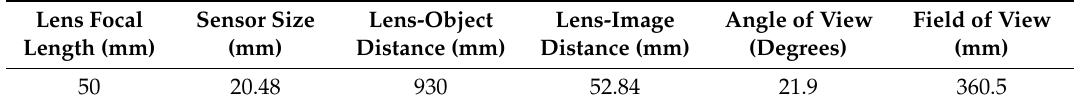
Table 1. Field of View Summary.